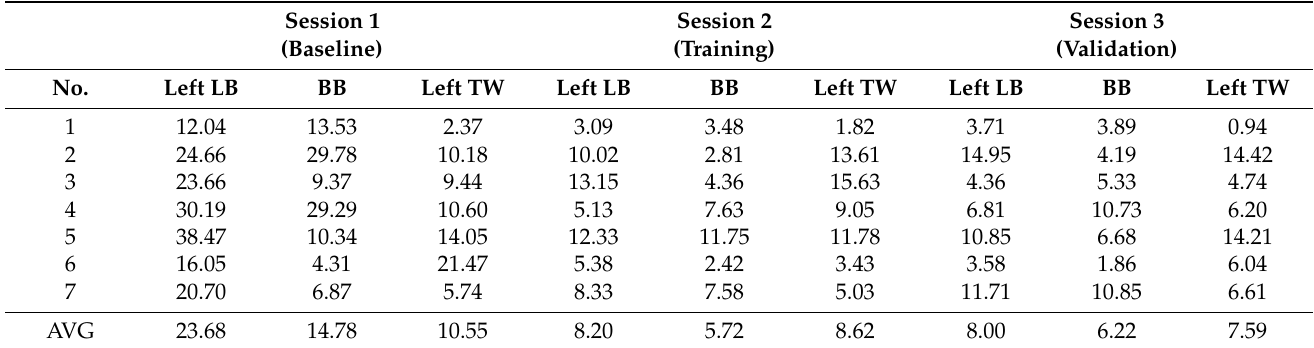
Table 3. Maximum valley values in